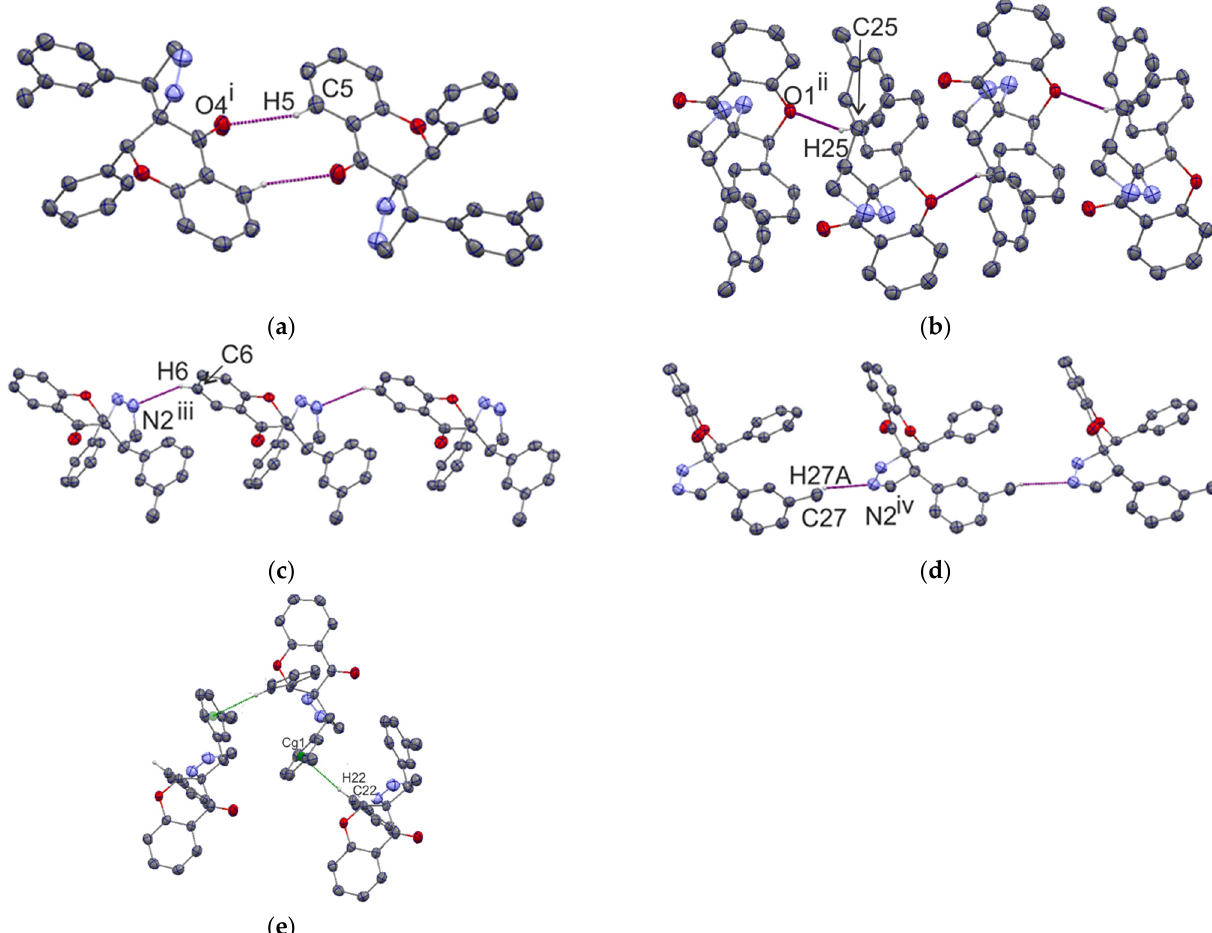
Figure 4. Fragment of the crystal packing of compound I , showing the formation of the R 22 (10) ring ( a ), C7 chain along [010] ( b ), C8 chains along [100] and [001] ( c , d ), and C–H… π interaction ( e ). The second substructure is chain C(7) along the [010] direction formed by a C25–H25…O1 ii hydrogen bond (symmetry code (ii): − x, y − 1/2, − z + ½) (Figure 4b). The N2 atom is an acceptor for C6–H6…N2 iii (symmetry code (iii): x − 1, y, z) and C27–H27A…N2 iv (symmetry code (iv): x, − y + 1/2, z + ½) hydrogen bonds, which are produced by both C(8) chains along the [100] and [001] direction, respectively (Figure 4c,d). In addition, the crystal lattice is stabilized by C22–H22 . . . Cg(1), related by the symmetry 1 − x, y + 1/2, 1/2 − z interaction with the geometrical parameters H22...Cg(1) 2.61 Å, C22 . . . Cg(1) 3.553 Å, and <C22-H22 . . . Cg1 172 ◦ (Figure 4e), producing a chain along the [010] direction. In the case of the crystal structure of compound II , molecules create the chains C(6), C(8), and C(4), propagating along the [010], [100], and [010] directions, with the respective hydrogen bonds: C12–H12B . . . O1 v , C24–H24 . . . O4 vi , and C11–H11 . . . N1 v (symmetry codes (v): 1/2 − x, − 1/2 + y, 1/2 − z; (vi): 1 + x, y, z ) (Figure 5a,b). Two hydrogen bonds, C12-H12B . . . O1 v and C11-H11 . . . N1 v , form the ring R 22 (8) (Figure 5a). The C–H . . . π interaction is also observed in the crystal lattice, and C7 acts as a donor in the C7–H7 . . . Cg(2) interaction connecting two molecules related by the inversion center (Figure